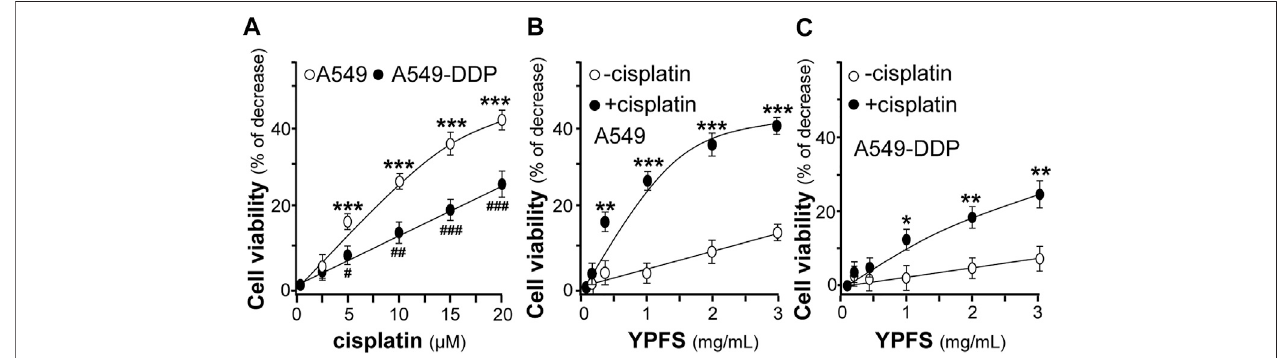
FIGURE2| YPFSpotentiatescytotoxicactivityofcisplatininculturedA549andA549-DDPcells. (A) :ThecytotoxicactivityofcisplatinagainstculturedA549/A549- DDPcells (B): SynergyofYPFSandcisplatinincytotoxicactivityinculturedA549cells. (C): SynergyofYPFSandcisplatinincytotoxicactivityinculturedA549-DDPcells. A549/A549-DDP cells in a logarithmic phase were seeded (5,000/well) in 96-well plates and allowed to adhere overnight. Cells were then treated with drugs for 48 h. Cisplatin at 2.5 µM (non-toxic dose) was co-applied with YPFS to test the synergistic effect in cell viability. MTT assay was applied to determine the cytotoxic activity. Values are expressed as % of increase, as compared to control group (no drug), in mean ± SEM, n (cid:2) 3. * or # , p < 0.05, ** or ## , p < 0.01, *** or ### , p <